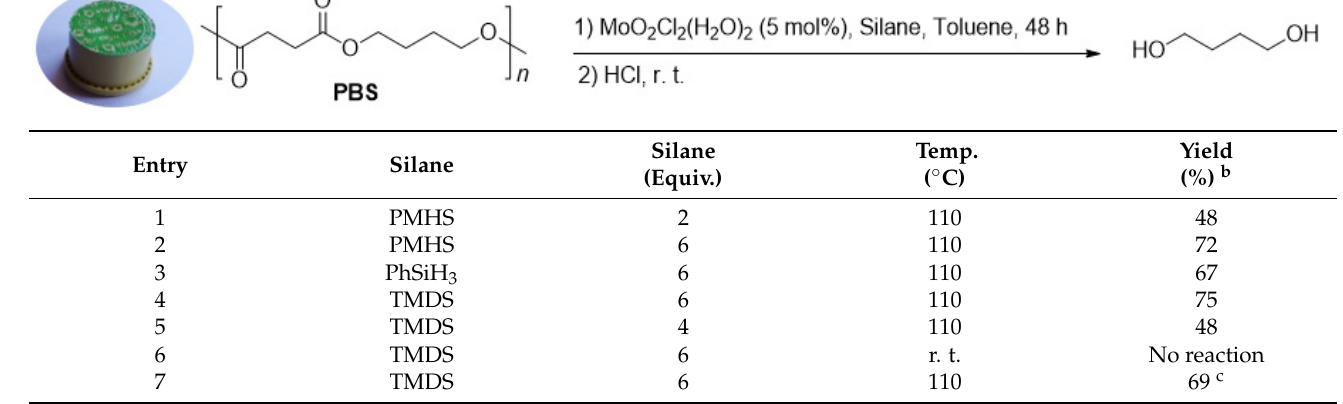
Figure 3. Use of MoO 2 Cl 2 (H 2 O) 2 in consecutive reductive depolymerizations of P4HB. The reactions were carried out using MoO 2 Cl 2 (H 2 O) 2 (5 mol%) by successive additions of P4HB (0.5 mmol) and TMDS (1.5 mmol) to the reaction mixture, without separating the catalyst at the end of each reaction. Yields were determined by 1 H NMR spectroscopy, using mesitylene as an internal standard. Table 2. Reductive depolymerization of PBS with the catalytic system MoO 2 Cl 2 (H 2 O) 2 /Silane a .